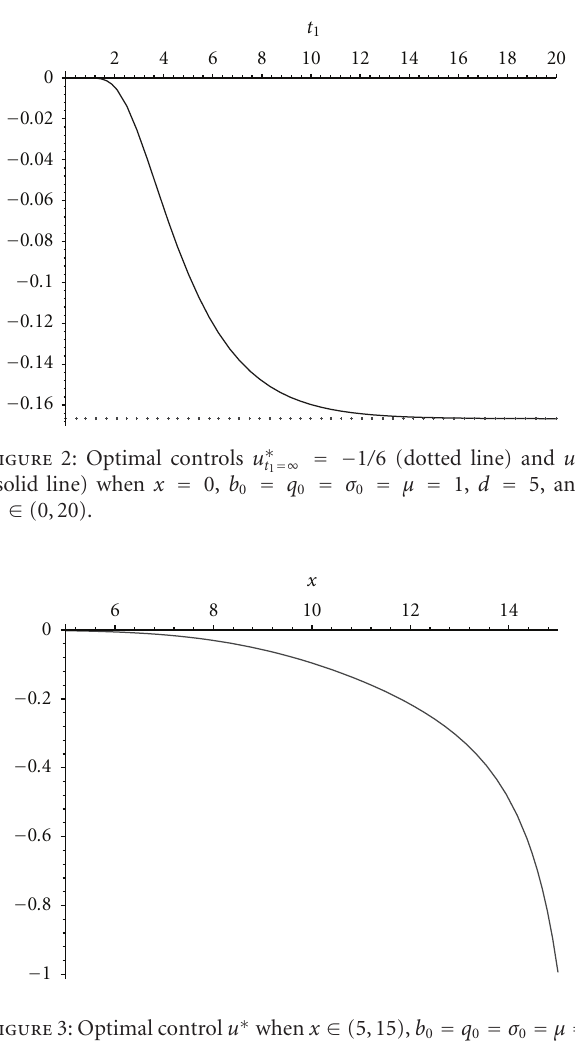
Figure 3: Optimal control u ∗ when x ∈ (5,15), b 0 = q 0 = σ 0 = μ = 1, d = 15, and t 1 =